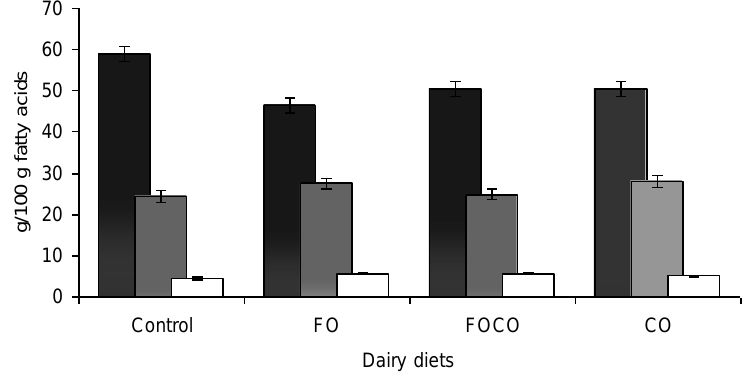
Figure 2. Proportion of saturated, mono and poly unsaturated fatty acids in dairy cows fed diets containing fish (FO) and canola oil